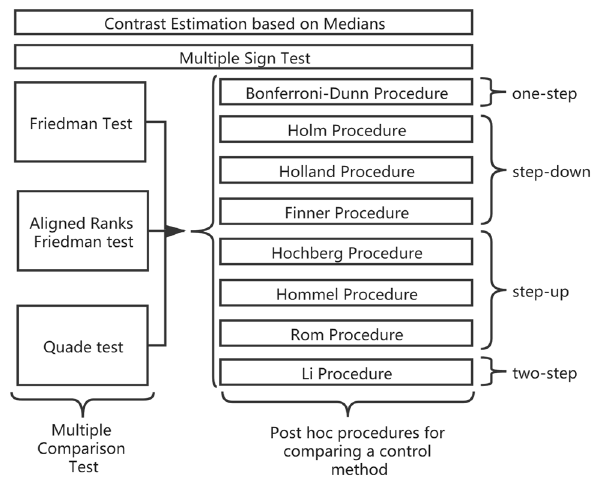
Fig. 1 Nonparametric Statistical Tests